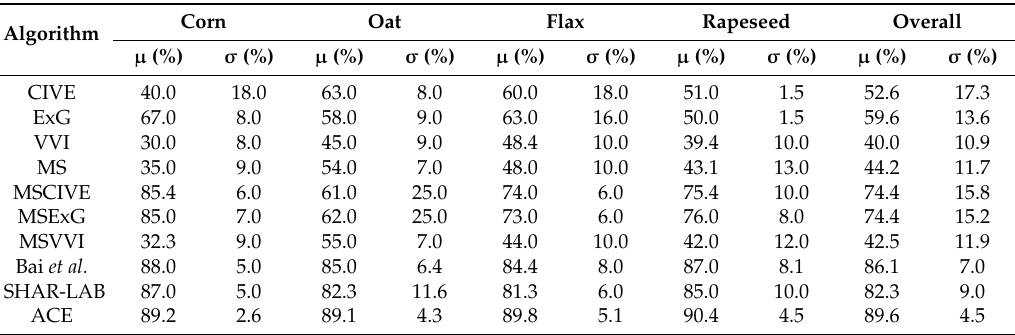
Table 1. Mean segmentation accuracy and standard deviations for the ten segmentation algorithms evaluated. Accuracies are shown for each crop and for all crops